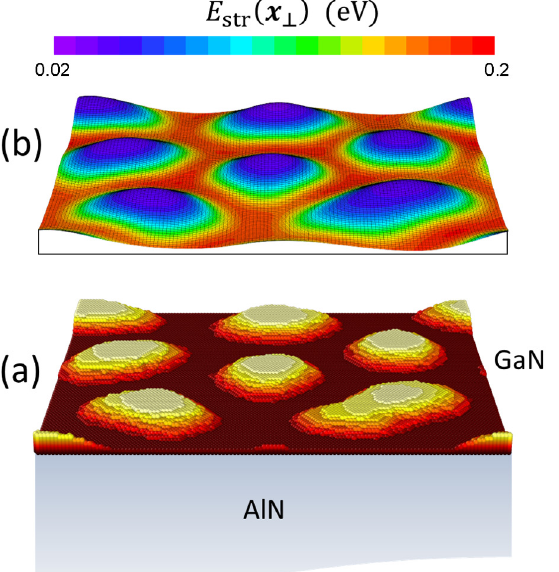
Figure 2. Schematic illustration of an epitaxial GaN layer on a semi-infinite AlN substrate. Both the original discrete description { h I } ( a ) and the smoothed version h ( x ⊥ ) ( b ) of the surface morphology are shown. The topography in part ( b ) is overlaid by a color map representing the strain energy E str ( x ⊥ ) , as calculated within continuum elasticity theory (see